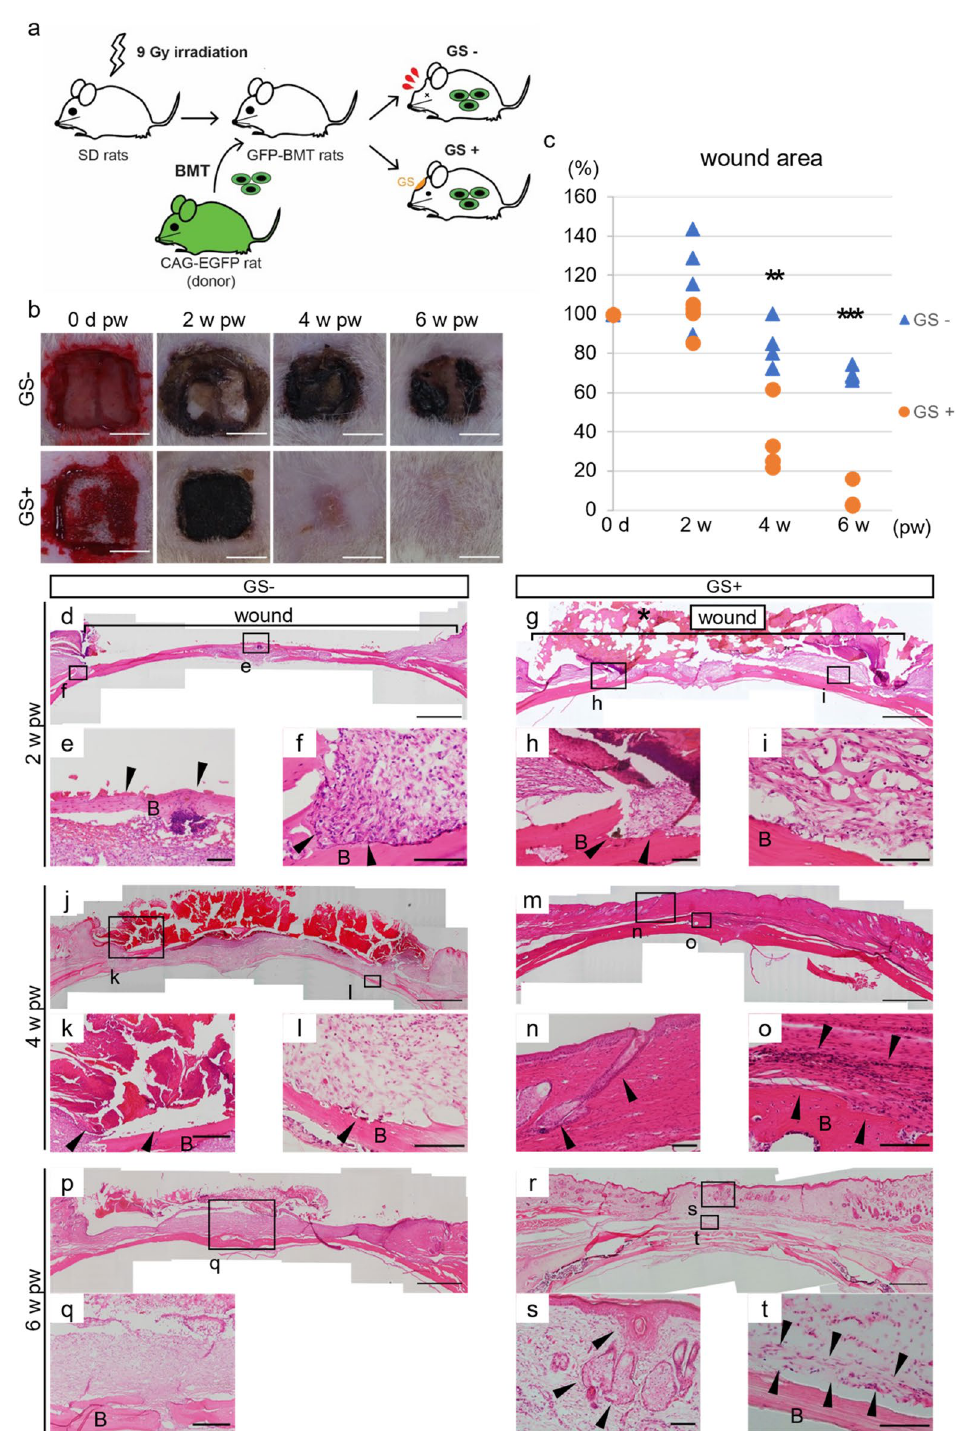
Figure 2. Heterogeneous tissue regeneration by GS application occurs in deep wounds with periosteal defects in a BMT rat model. ( a ) Schema of establishing BMT rats. After 9 Gy irradiation exposure, 1 × 10 8 bone marrow cells isolated from green fluorescent protein (GFP) rats were injected into the tail vein of recipient rats. One month later, skin/subcutaneous tissue/periosteum defects were made in the calvaria with/without GS application. n = 4 for each. ( b ) Gross appearance of the deep wounds with or without GS application is shown at various time points. ( c ) Wound area with or without GS application was quantified. ( d – t ) H and E staining of the wounds with or without GS application are shown. The experiments were repeated twice. Scale bars, 5 mm in c, 1 mm in ( d , g , j , m , p , t ) 100 μm in ( e , f , h , i , k , l , n , o , r , u , v ). Arrowheads, see the text. B bone cortex. *P < 0.05, * *P < 0.01, *** P <